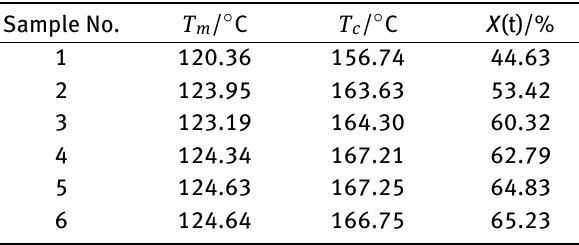
Table 3: Non-isothermal crystallization parameters of the experi- mental materials Sample